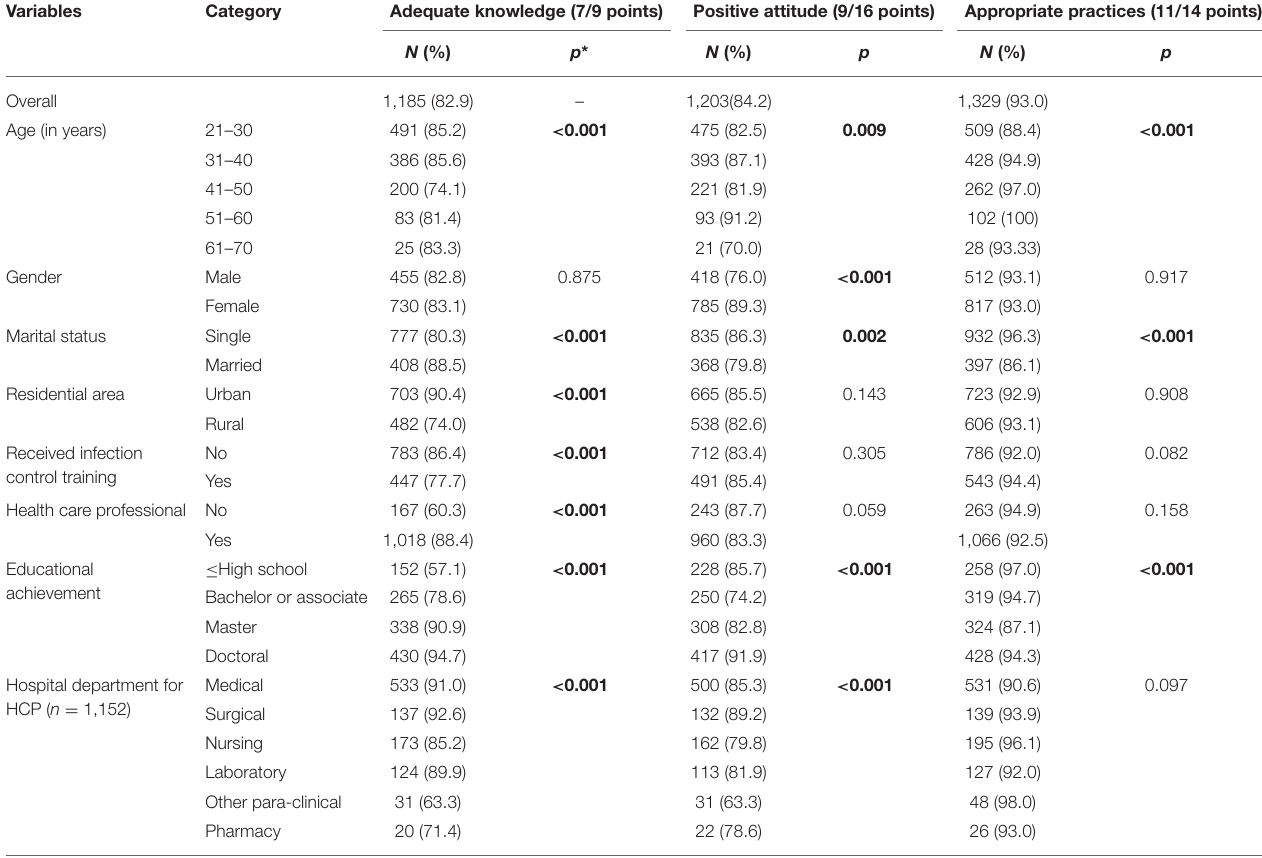
TABLE 5 | Distribution of adequate knowledge, positive attitude, and appropriate practices based on the demographics and characteristics of the participants.